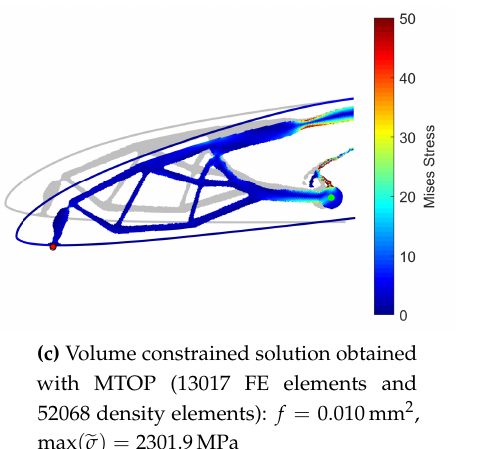
Figure 11. Comparison of solutions for the compliant mechanism rib example.